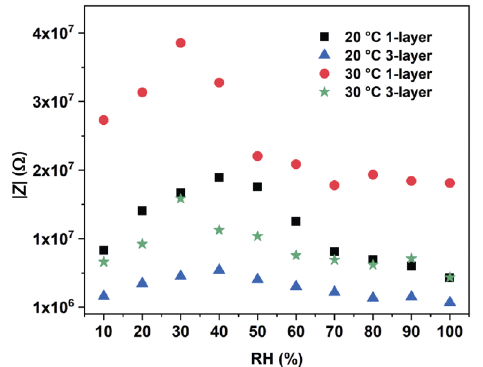
Fig. 6 Impedance variation with RH (at 400 Hz) for the TiO 2 /WO 3 structures at working temperatures of 20 and 30 ℃ .